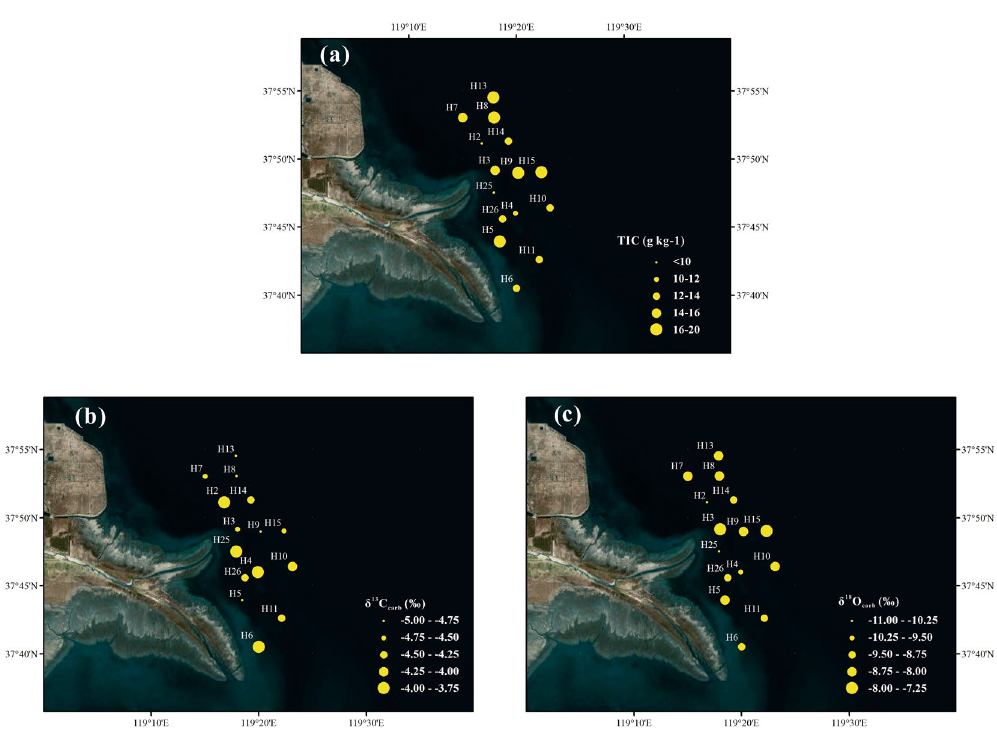
Figure 4. Spatial distributions of (a) TIC (g kg − 1 ), (b) δ 13 C carb (‰), and (c) δ 18 O carb (‰) in surface sediments of the Yellow River Estuary. The maps were generated by ArcGIS 10.2